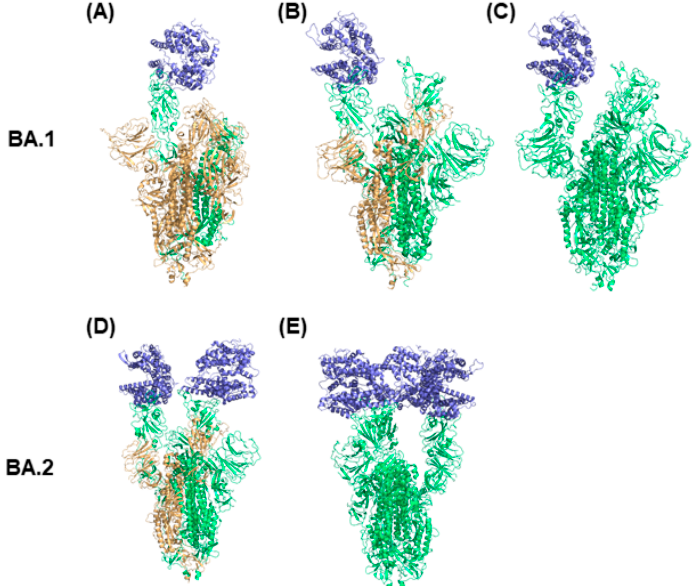
Figure 2. Distinct conformations of Omicron spike protein with ACE2. The conformations ( A – C ) are BA.1 Omicron spike protein complexed with ACE2. The conformations ( D , E ) are BA.2 Omicron spike protein complexed with ACE2. The spike protein chain with RBD down conformation is marked in orange and the spike protein chain with RBD up conformation is presented in green. ACE2 is colored in blue.